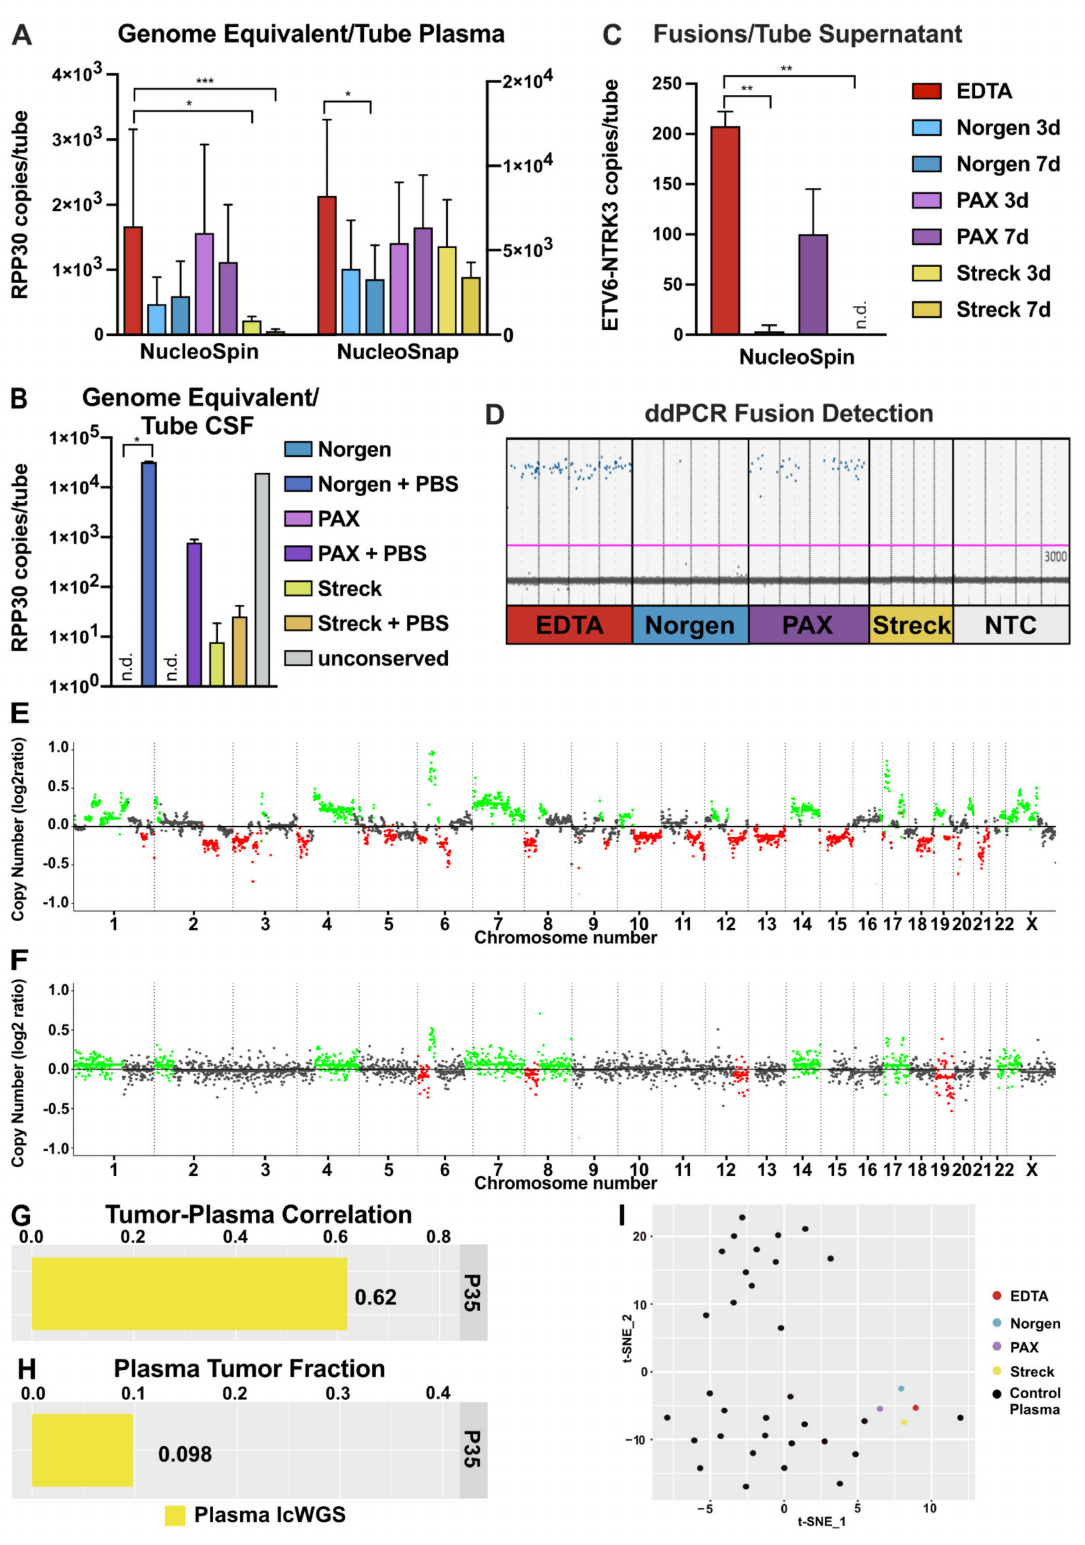
Figure 6. Cell-free nucleic acid validation after application of the improved pre-analytical protocol. ( A ) Genome equivalents represented as copies of the non-amplified genome region RPP30 per indicated plasma tube plotted for NucleoSpin (left) and NucleoSnap (right). Error bars indicate standard deviation ( n = 4). ** p < 0.01, *** p < 0.001 as determined by